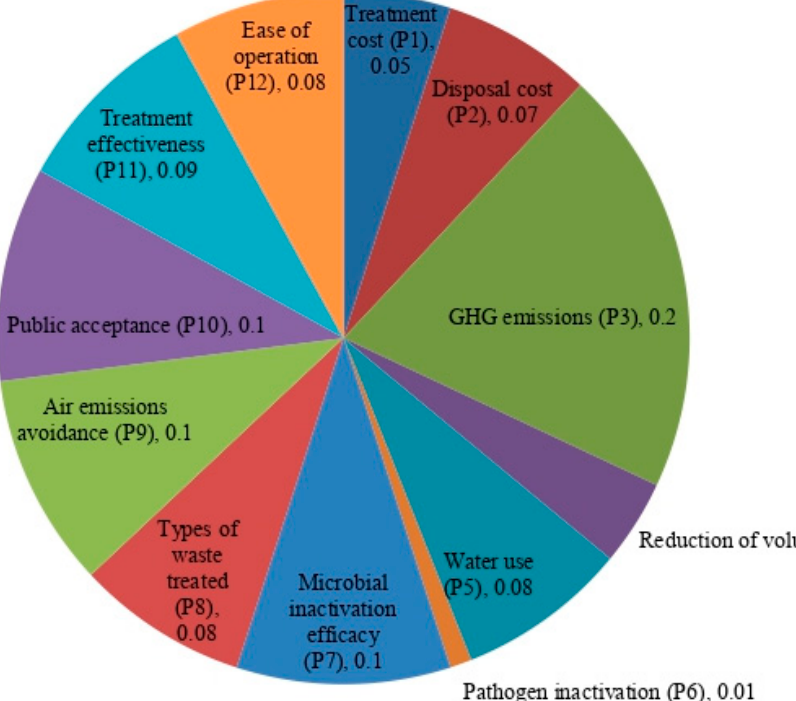
Figure 4. Criteria weight of WTE technology for MSW treatment assessment.